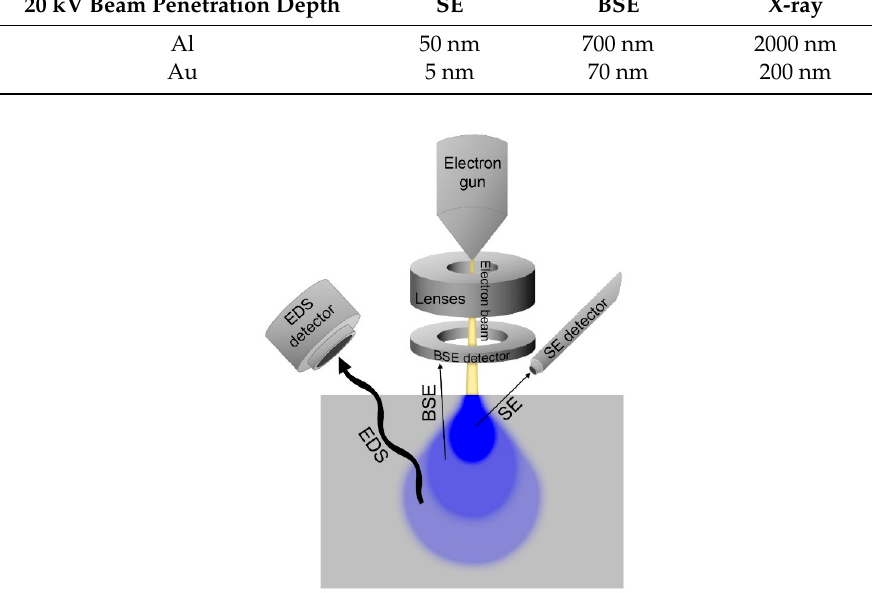
Figure 7. Scheme of a SEM with SE, BSE and EDS volume of interaction and detectors.